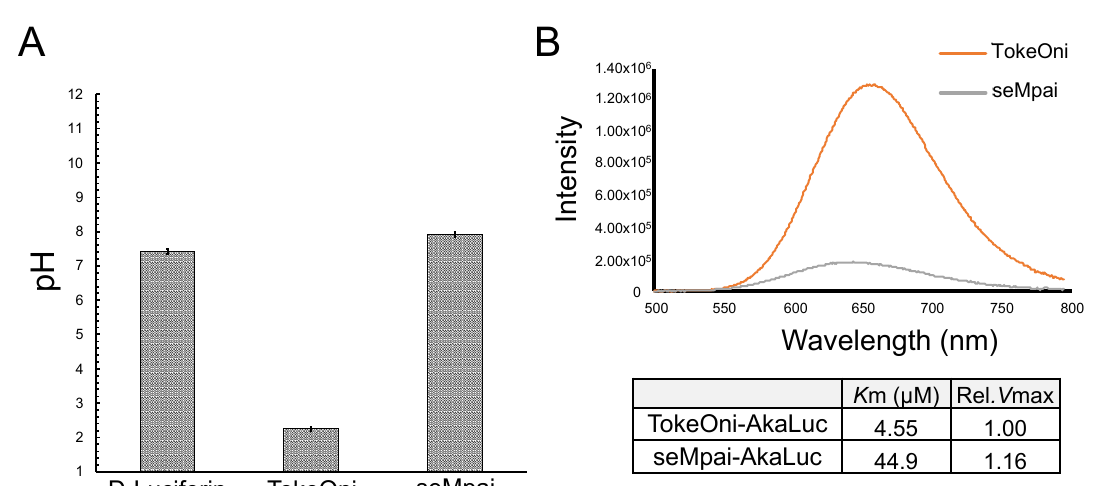
Figure 3. Measurements of pH value and bioluminescence of luciferin analogues with AkaLuc. pH values of 10 mM solutions of D-luciferin, TokeOni and seMpai ( n = 3) ( A ). In vitro reaction of luciferin analogues with AkaLuc ( B ). The table shows the value of Michaelis constant ( K m ) and relative maximal velocity (rel. V max ) for luciferin analogues with AkaLuc.